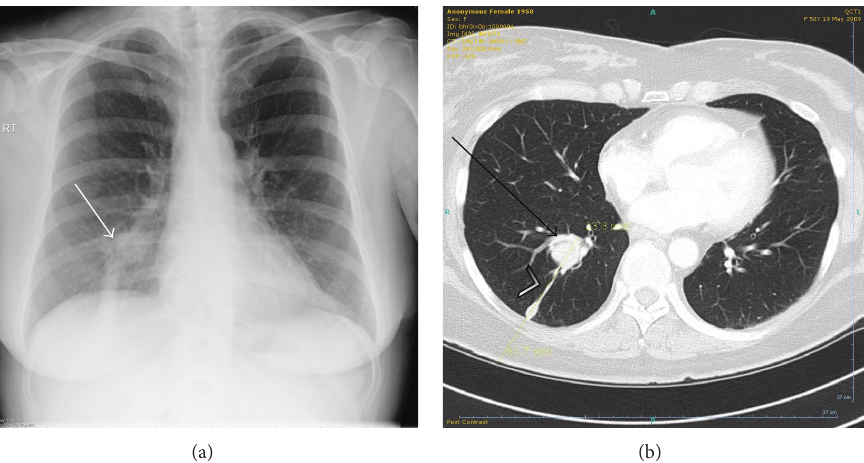
Figure 1: (a) Chest X-ray showed a 2cm round opacity (white arrow) over the lower end of the right hilum with an inferiorly extending band shadow. (b) Transverse section chest contrast-enhanced computed tomography confirmed a 26mm by 23 mm irregularly round lesion (black arrow) located at the bifurcation of the posterior segmental division of the lower lobe bronchus. There is further extension posteroinferiorly of the irregular soft tissue (arrowhead) contiguous from the lesion towards the costophrenic angle and diaphragm with pleural thickening.